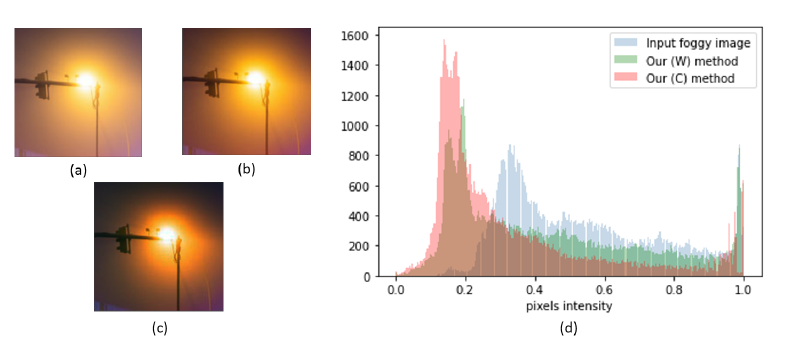
Figure 17. Comparison on a glow patch: ( a ) input foggy image, ( b ) restored patch with our white fog algorithm, ( c ) restored patch with our colored fog algorithm, ( d ) histogram of the intensity of each glow patch (glow images are Reprinted with permission from ref. [35]. Copyright 2021 Mark